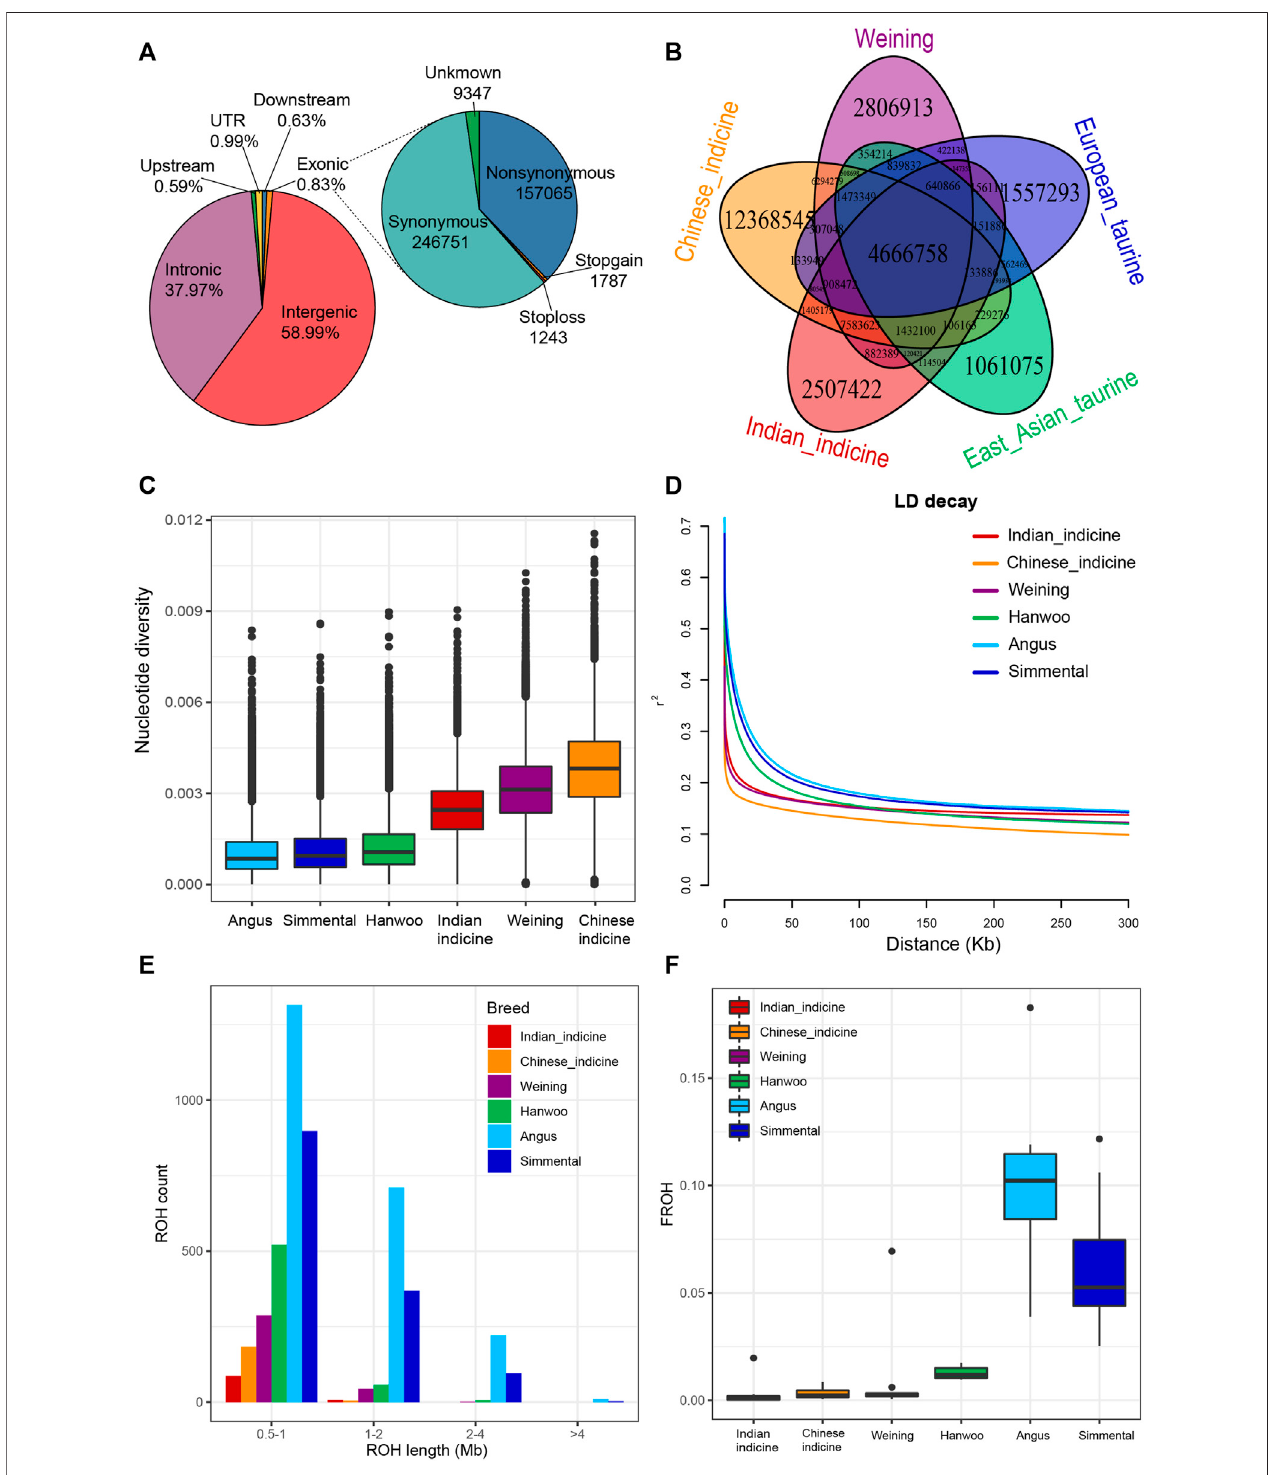
FIGURE 1 | Summary statistics for genomic variation. (A) . Functional classi fi cation of the detected SNPs. (B) . Speci fi c and shared SNPs between Weining and othercattlegroups. (C) .Genome-widedistributionofnucleotidediversityofeachbreed/populationin50-kbwindowswith20 kbsteps.Thehorizontallineinsidethebox indicates the median of this distribution; box limits indicate the fi rst and the third quartiles, and points show outliers. Data points outside the whiskers can be considered outliers. (D) .Genome-wide averageLDdecayestimated fromeach breed/population; (E) .DistributionofthetotalnumberofROHacrosschromosomes. (F) . F ROH of each